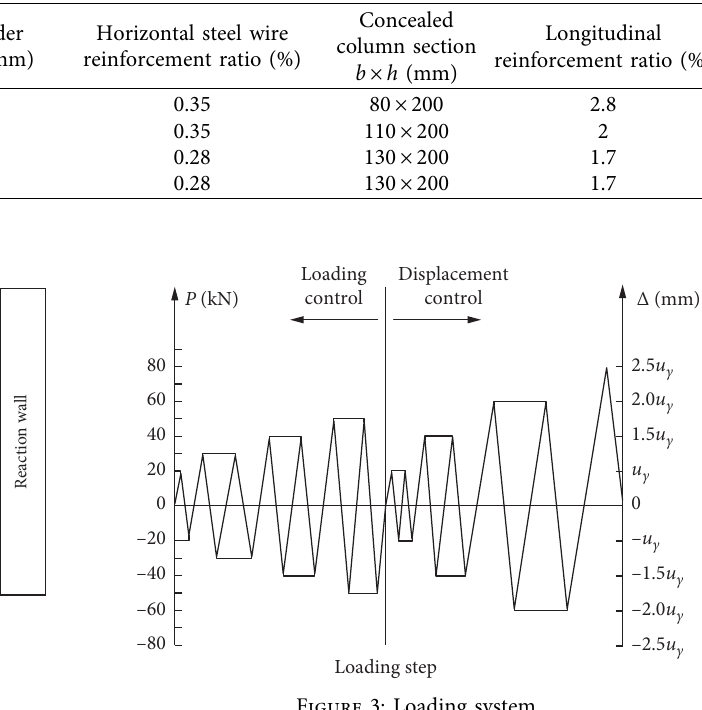
Table 1: Test piece overview.